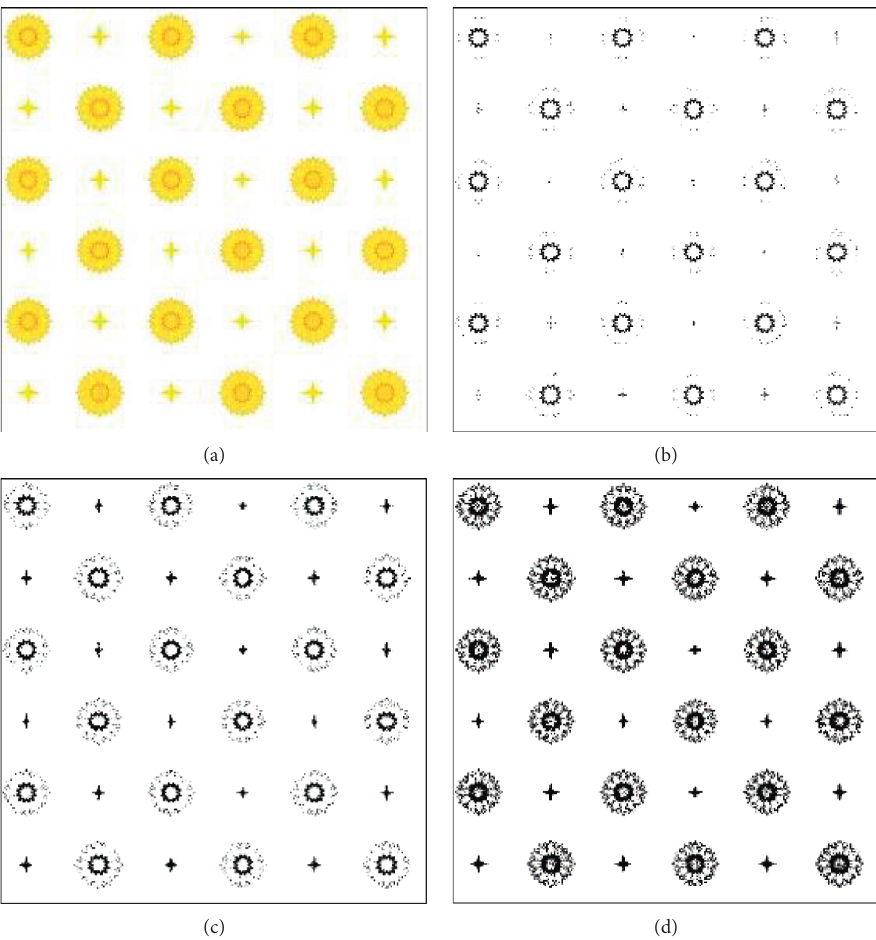
Figure 2: Segmentation result of a single pattern. (a) Original image; (b) 1D maximum entropy; (c) 2D maximum entropy t � maximum entropy t 3